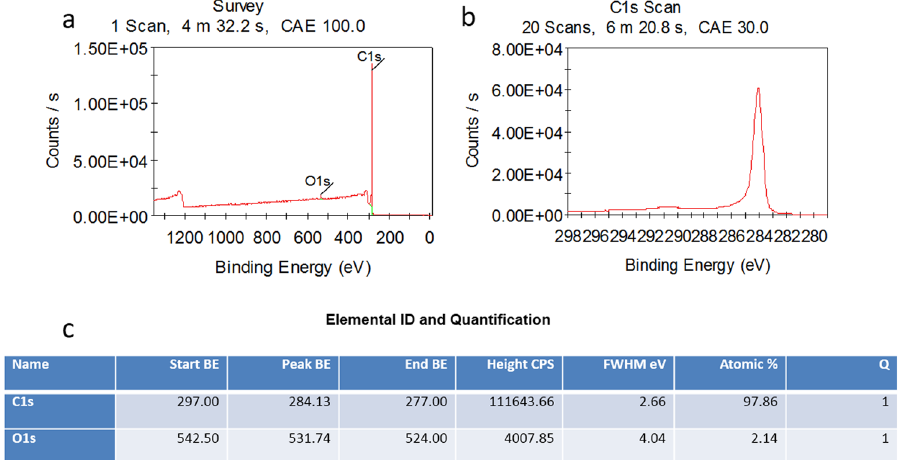
Figure 7. The XPS report of graphene powder. ( a ) XPS curves of all elements, ( b ) XPS curve of element carbon, ( c ) Elemental ID and Quantification.